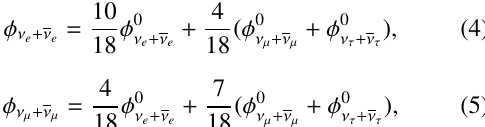
Figure 1. Neutrino fluences from extended emissions (EEs), plateau emission, prompt emission, and X-ray flare of SGRBs at the luminosity distance d L = 300 Mpc. We consider optimistic and moderate cases for EEs. This figure is reproduced from